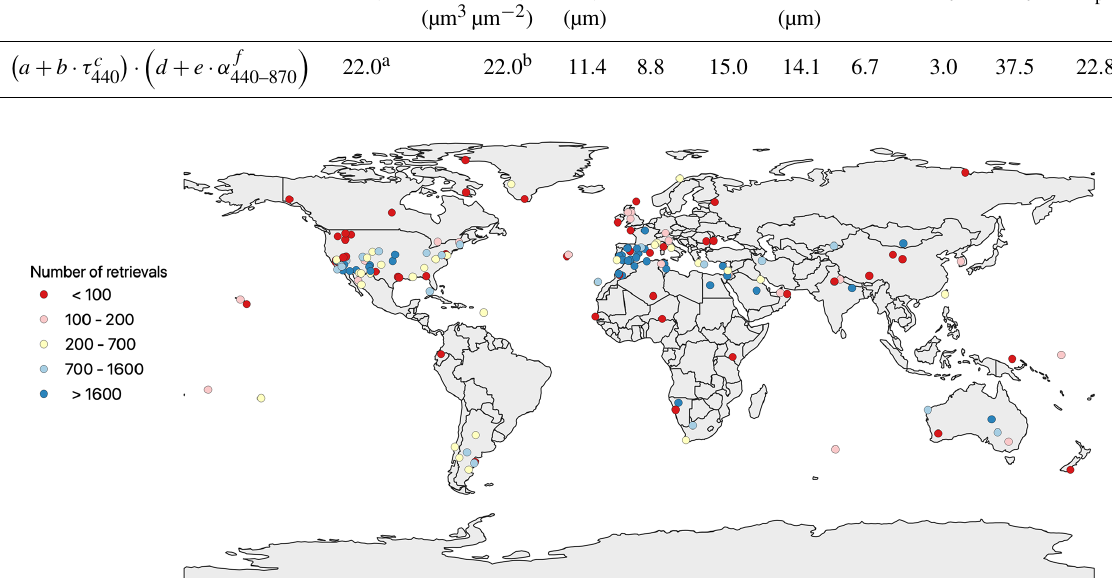
Figure 11. AERONET sites for which C vf is better represented than % C vf